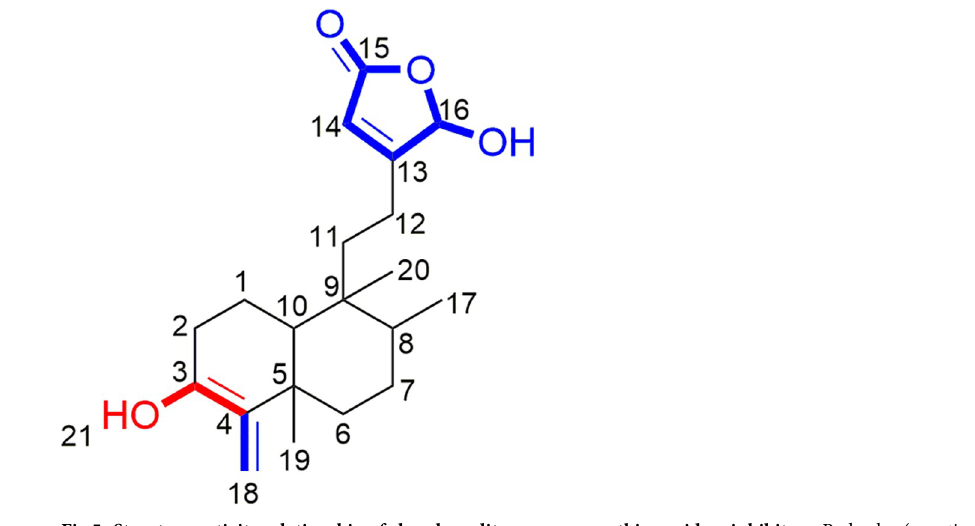
S1 Fig. Molecular dynamics simulations of compound 4 –XO protein complex.